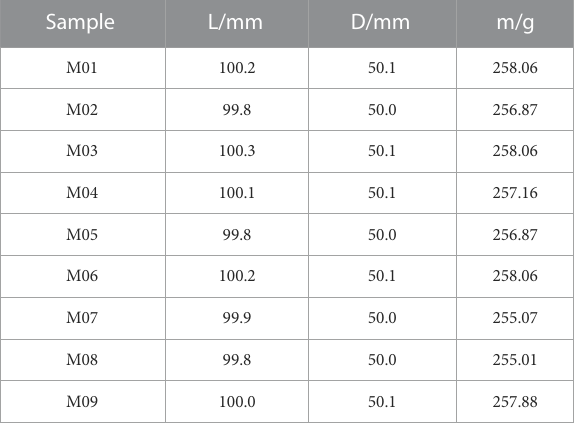
TABLE 1 Basic physical parameters of the specimen. Sample